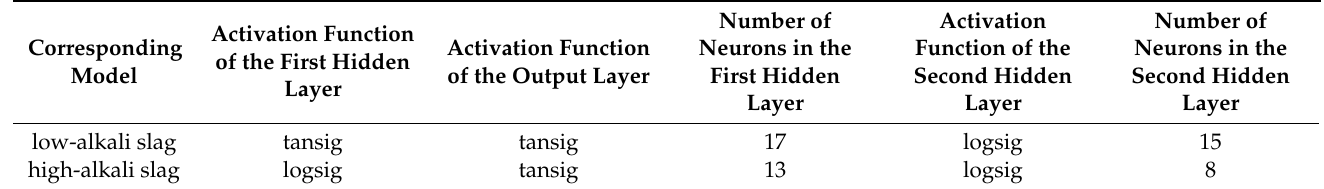
Table 2. Structure parameters of low-alkali and high-alkali slag viscosity prediction models.